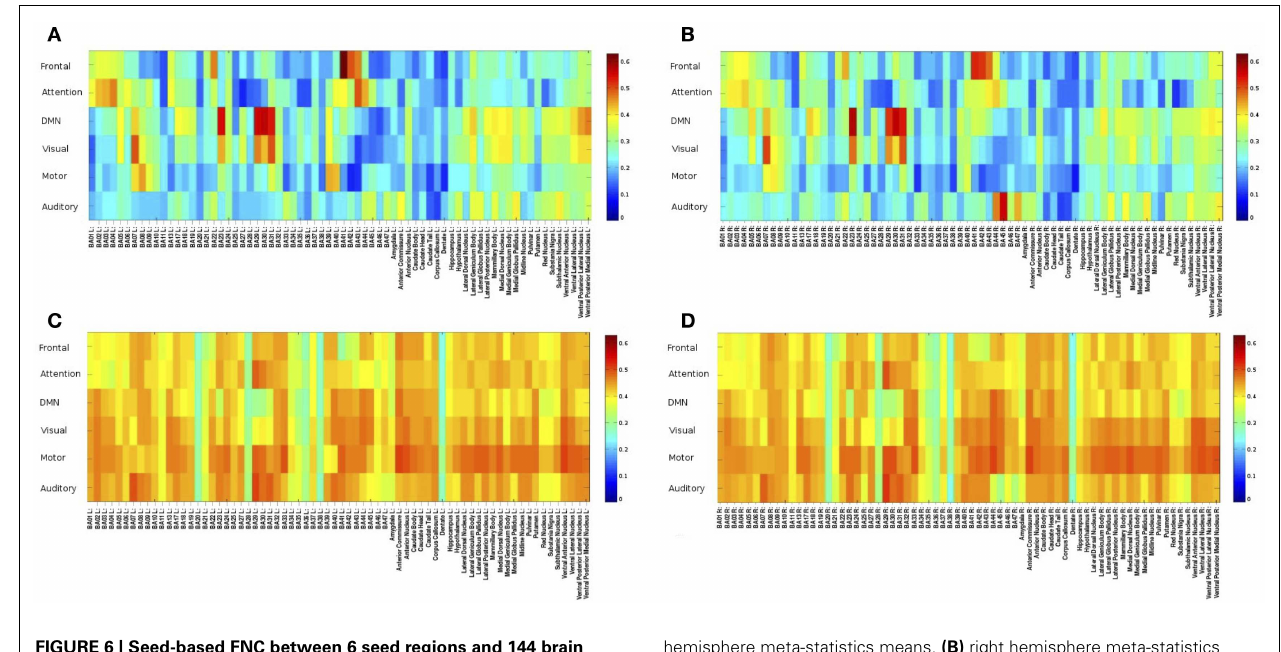
FIGURE 6 | Seed-based FNC between 6 seed regions and 144 brain regions using MEVI2 (TR: 136ms) and meta-statistics averaged across nine healthy subjects at the end of the scan . Spatial means of (A) left